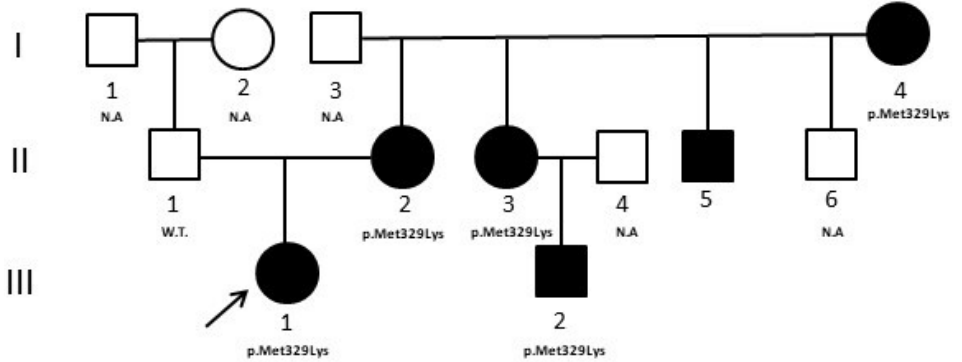
Figure 1. Case 1 pedigree. The pedigree shows the segregation of the HNF4A variant detected in the proband. Filled symbols indicate subjects with diabetes. W.T.= Wild type . N.A.= not analyzed. ↗ = proband.